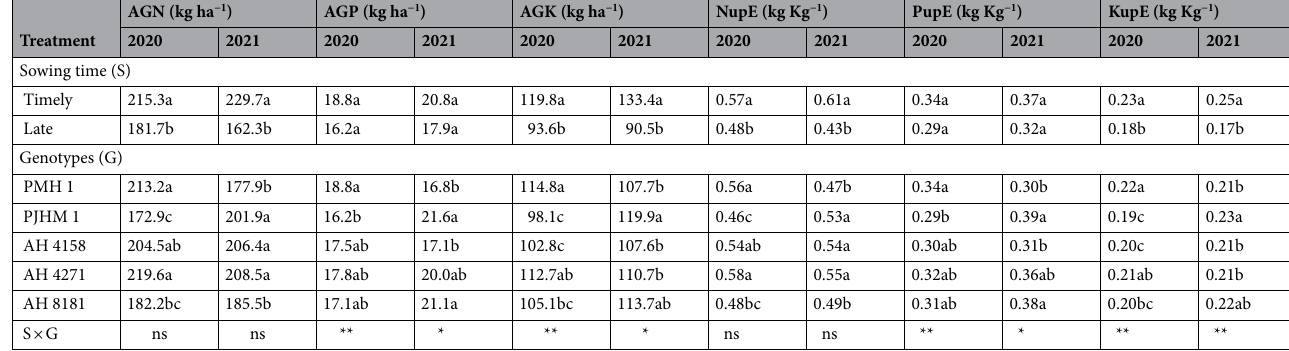
Table 4. Above ground nutrient uptake and nutrient uptake efficiencies of maize genotypes under timely and late sown conditions. AGN: Total above ground nitrogen uptake, AGP: Total above ground phosphorus uptake, AGK: Total above ground potassium uptake, NupE: Nitrogen uptake efficiency, PupE: Phosphorus uptake efficiency, KupE: Potassium uptake efficiency. Within, sowing time and genotypes, different letters indicate the significant difference (p ≤ 0.05); The S × G implies the interaction between sowing time and genotypes; **Significant at ( p ≤ 0.01); *Significant at p ≤ 0.05; ns: not